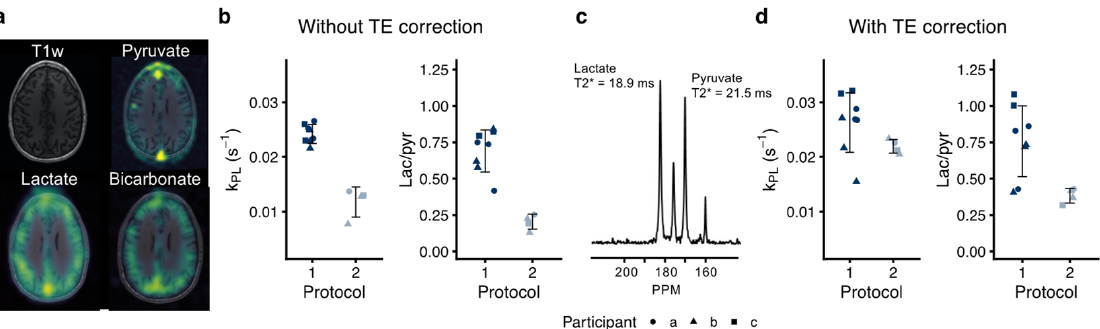
Figure 4. Agreement of pyruvate-to-lactate conversion with hyperpolarized [1- 13 C]pyruvate be-